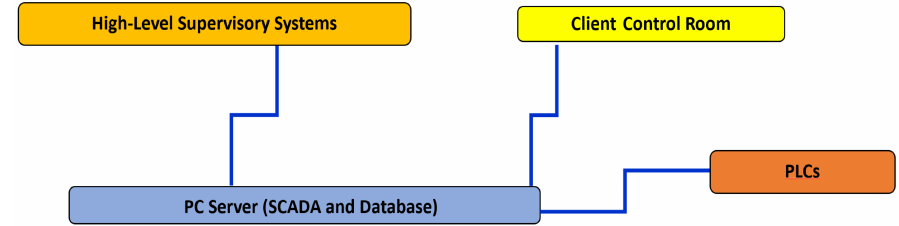
Figure 6. Designed architecture for data acquisition and